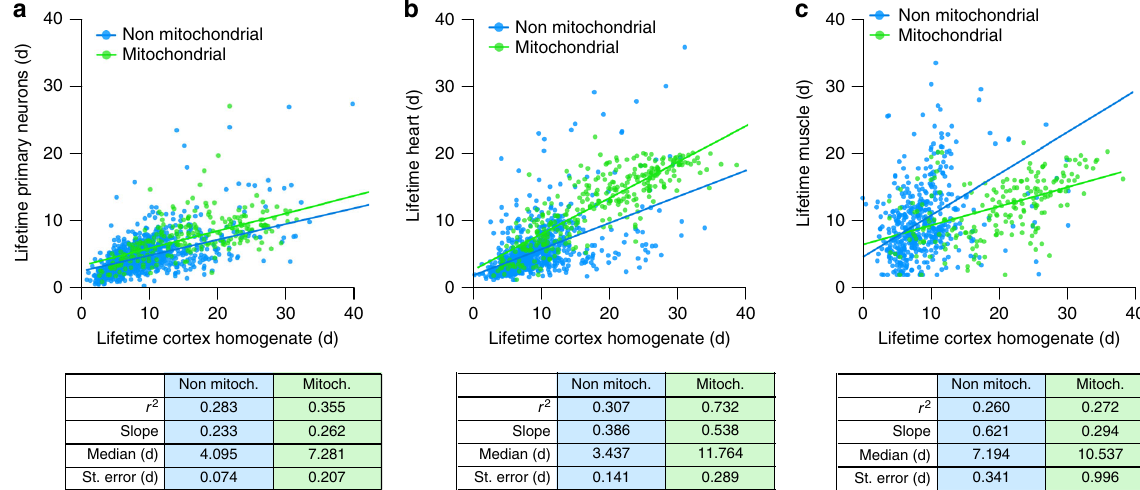
Fig. 8 Protein lifetimes across different cells or tissues. a , b Scatter plots of the lifetimes in the cortex homogenate versus the lifetimes of primary rat neurons (published elsewhere 7 ; a ). Non-mitochondrial proteins are represented in blue while mitochondrial proteins are represented in green. The lifetimes of proteins in vitro are shorter than in vivo, both for mitochondrial and non-mitochondrial proteins. Even accounting for this overall difference, presynaptic proteins are shorter living in cultured cells than in vivo (see Supplementary Table 3 for details). This difference might be due to the fact that culture neurons are still growing and developing axons and synapses at the time of the measurements. b Scatter plots of the lifetimes in the cortex homogenate versus the lifetimes in heart samples. In the heart the turnover of proteins is overall faster than in the brain, but the mitochondria proteins tend to be longer-lived than the rest of the proteome. The gene ontology analysis suggests that the main lifetime differences observed between the two tissues are at the level of cell cycle and metabolic processes, in line with their different requirements of the two tissues (Supplementary Table 3). c Scatter plots of the lifetimes in the cortex homogenate versus the lifetimes of skeletal muscle (gastrocnemius). Protein turnover in muscle is also faster than in the brain. If compared with the heart, the mitochondrial turnover in the muscle is relatively faster, probably re fl ecting a difference in the metabolic requirements of the two tissues (please compare b and c ). In the muscle the turnover of proteins involved in DNA biosynthesis is relatively faster than in the brain, probably because of the limited cell renewal and DNA synthesis observed in the nervous system (Supplementary Table